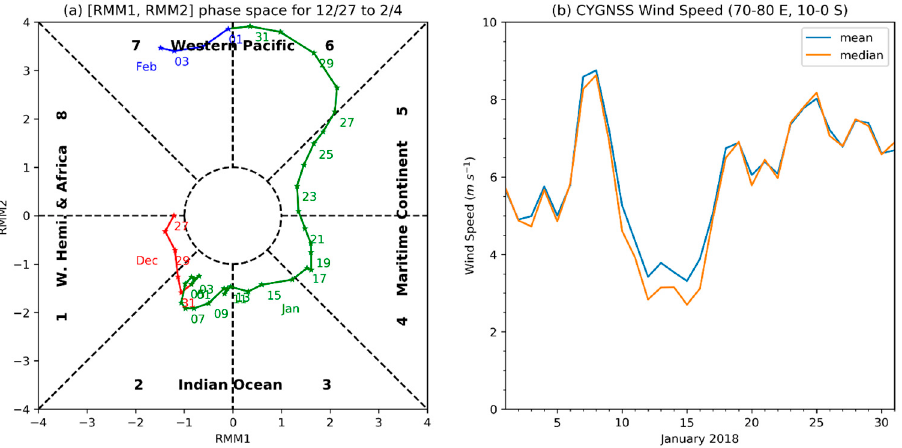
Figure 1. ( a ) RMM index phase diagram from 27 December 2017 to 4 February 2018. Different color lines represent the different months (red for December, green for January, and blue for February); dates are annotated to the left of the values. Phases are labelled on the diagram. Points outside the circle indicate a significant MJO event, while phase triangles indicate its primary location. ( b ) CYGNSS daily wind speed averaged within 70°–80°E, 10°S–0°.